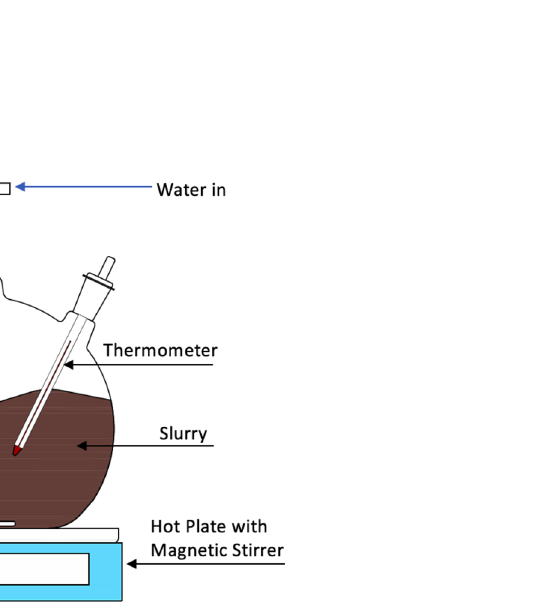
Figure 2. Schematic picture of the leaching